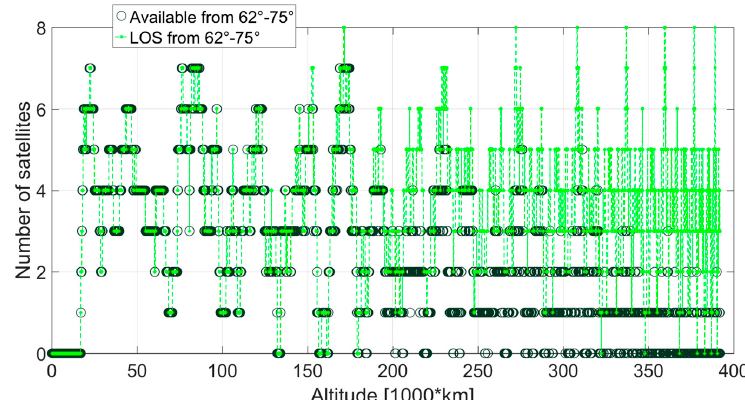
Figure 41. Visible satellites (in the line of sight (LOS)) and available satellites at the receiver’s position, for which the corresponding signal is transmitted at an angle between 62° and 75° from the transmitter’s boresight.